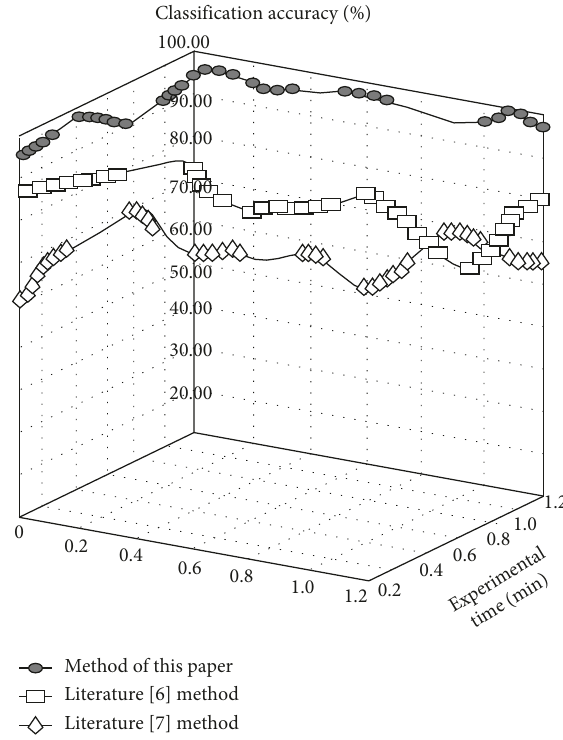
Figure 1: Comparison results of classification accuracy of the three algorithms.